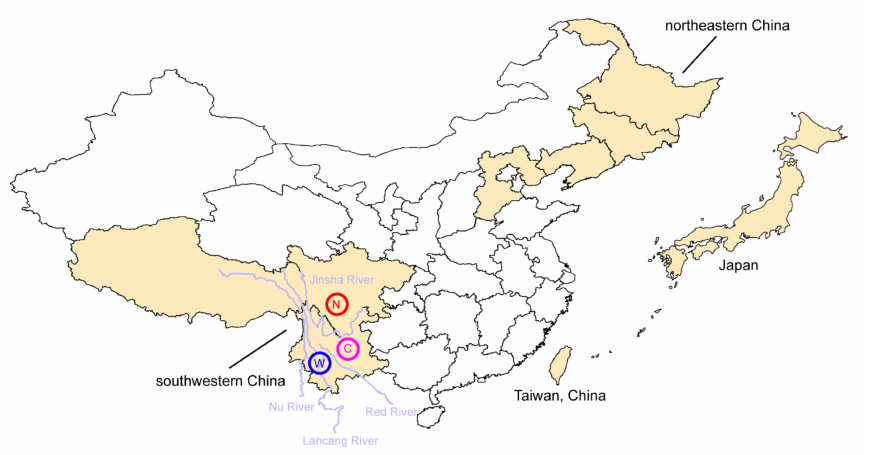
Figure 3. A map showing the distribution range (in yellow) and biogeographic patterns of Chinese black truffles. Tuber indicum can be found in southwestern China and three haplotype groups (N, north; C, central and W, west) were revealed, while T. himalayense can be found in southwestern China, northwestern China, Taiwan island of China and